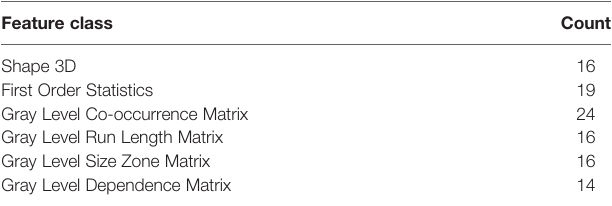
TABLE 2 | Six types of radiomics features and the number of them. Feature